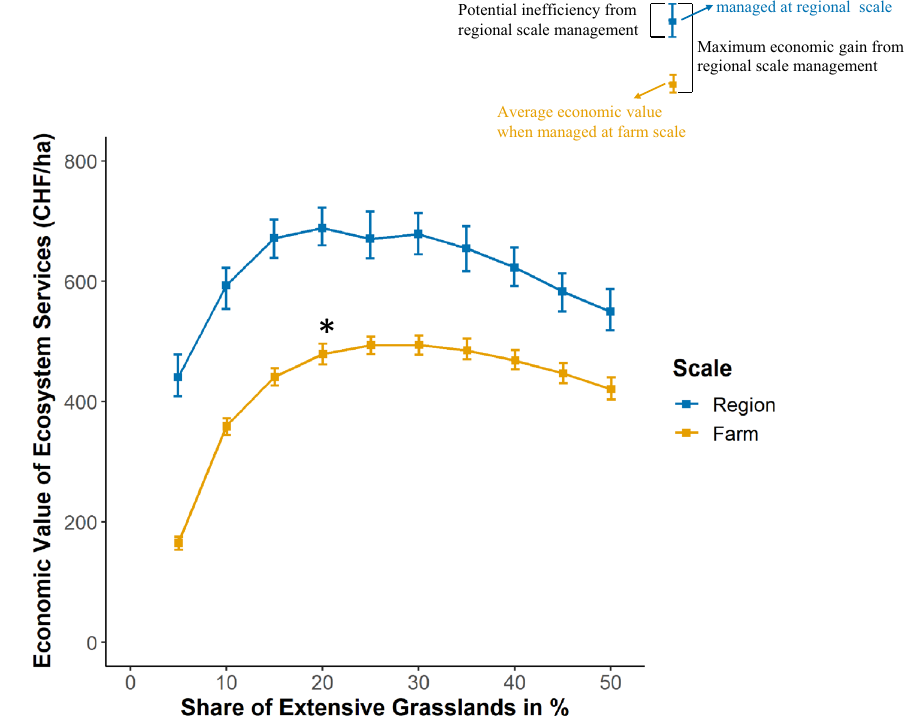
Figure 2. Economic value of three grassland ecosystem services with increasing shares of extensive grassland. Squares represent mean values compared to intensive land-use over 500 random allocations of four grassland types x i for two policy target levels q (region, farm) with increasing shares of extensive grassland (0–50%). Error bars show minimum and maximum values reflecting spatial variability in ecosystem service values. Economic valuation is based on average forage price and mean willingness to pay estimates as well as a carbon price equivalent to the Swiss CO 2 levy. The star (*) represents extent of extensive grassland use in the case study region in